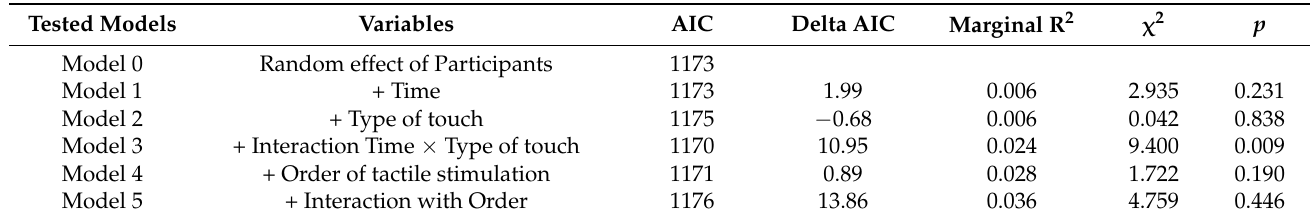
Table 5. Comparison between models predicting RMSSD. Note that smaller values of AIC indicate better fitting models.